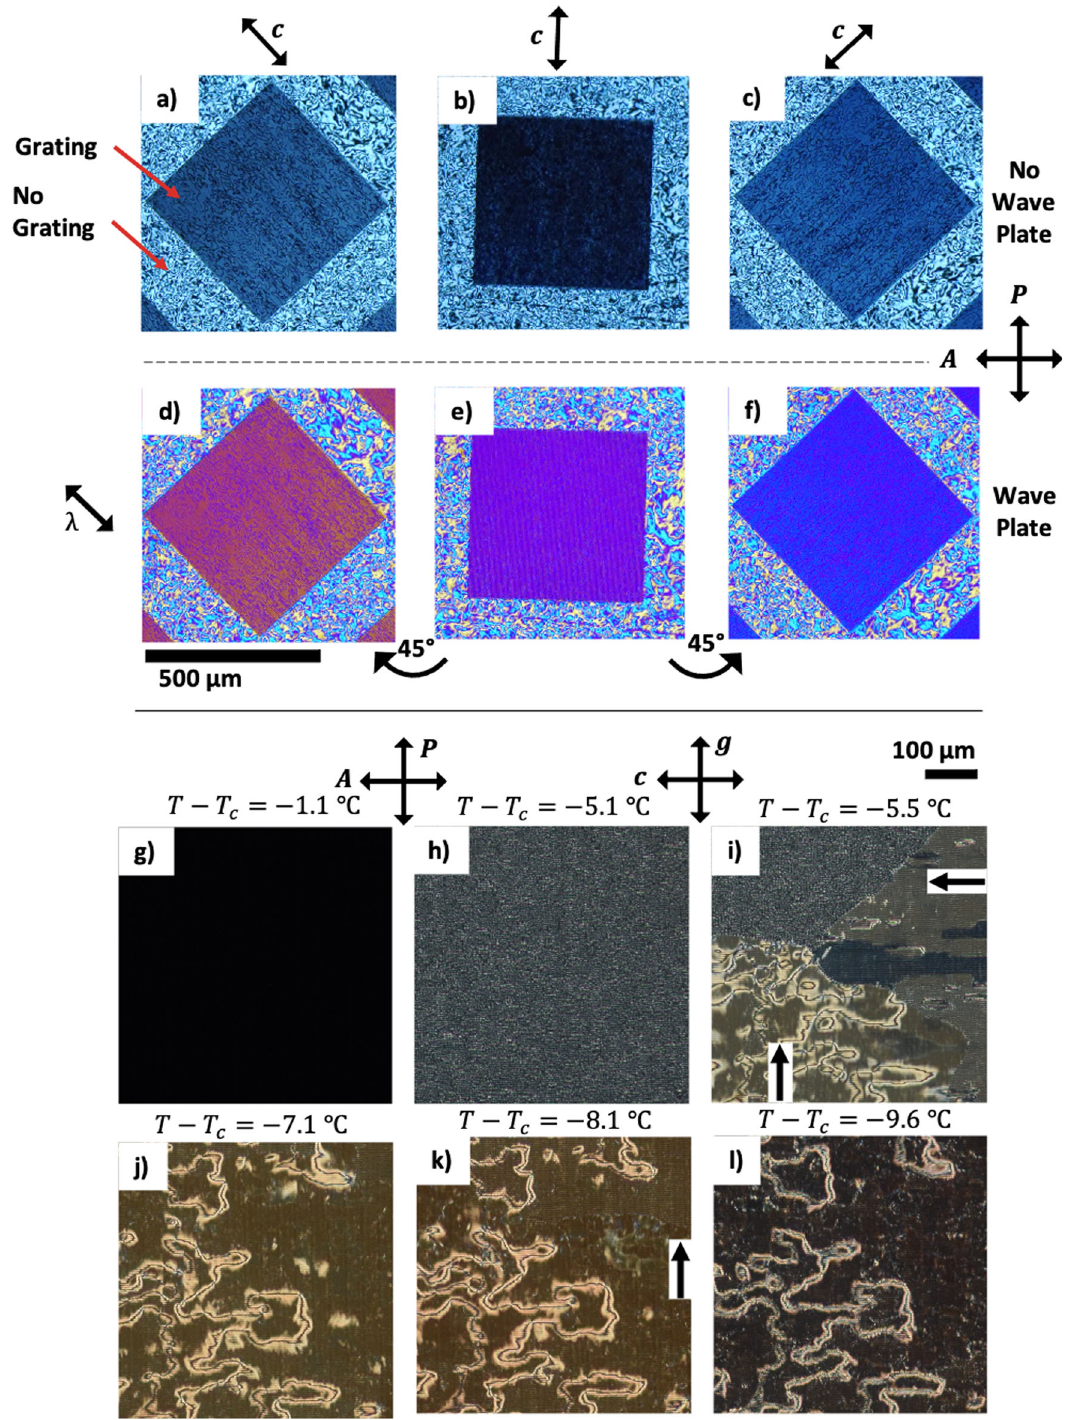
Fig. 3 Polarising optical microscope (POM) images of the SmC(*) alignment in the VGA-FLC device. a – f The alignment effects of homeotropic surface- relief gratings on the smectic c -director on a single grating with pitch of 4 µ m and peak-to-peak amplitude of 0.3 ± 0.1 µ m SU-8 grating, with d = 6.4 ± 0.6 μ m, and fi lled with SCE13-R. a – c Rotations of the gratings between crossed polarisers, showing regions with no gratings showing a schlieren texture, and regions with gratings inducing a preferred c -director orientation. d – f A full wave plate oriented at 45° to crossed polarisers reveals the c -director orientation is perpendicular relative to the grating vector g . This reveals that the smectic layers form an A 21 elastic deformation. g – l POM images on cooling VGA-FLC Device 1 (Table 1) at 0.5 °C min − 1 into the SmC(*) phase. g T = 59.7 °C ( Δ T = 1.1 °C) The dark texture at the SmA to SmC* transition before undulating textures appear, showing good homeotropic alignment. h T = 55.7 °C ( Δ T = 5.1 °C) Carpet-like textures arise below the SmA to SmC(*) transition. i T = 55.2 °C ( Δ T = 5.6 °C) Carpet textures dissipate behind a dislocation line of layer formation. The number of defects on the grating texture depends on the direction of layer formation fl ow relative to the grating vector g . j T = 53.7 °C ( Δ T = 7.1 °C) Texture free of undulations. k T = 53.7 °C ( Δ T = 7.1 °C) Undulations continuously appear and dissipate. l T = 51.2 °C ( Δ T = 9.6 °C) The texture on further cooling become optically dark and well aligned, away from the disclinations.